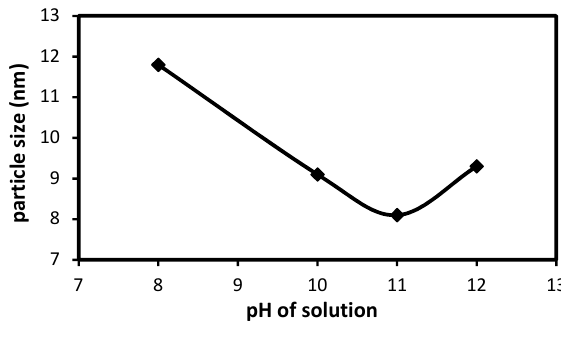
O MNPs (Temp: 45 °C, stirring rate: 800 rpm). 3 4